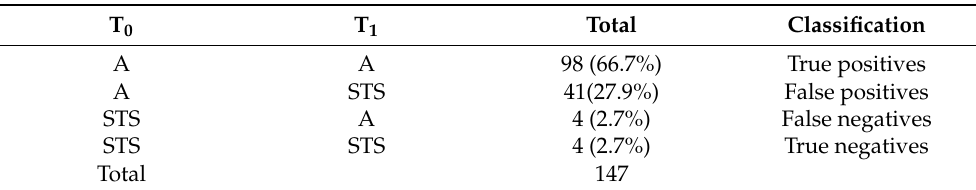
Table 3. Outcome classification.